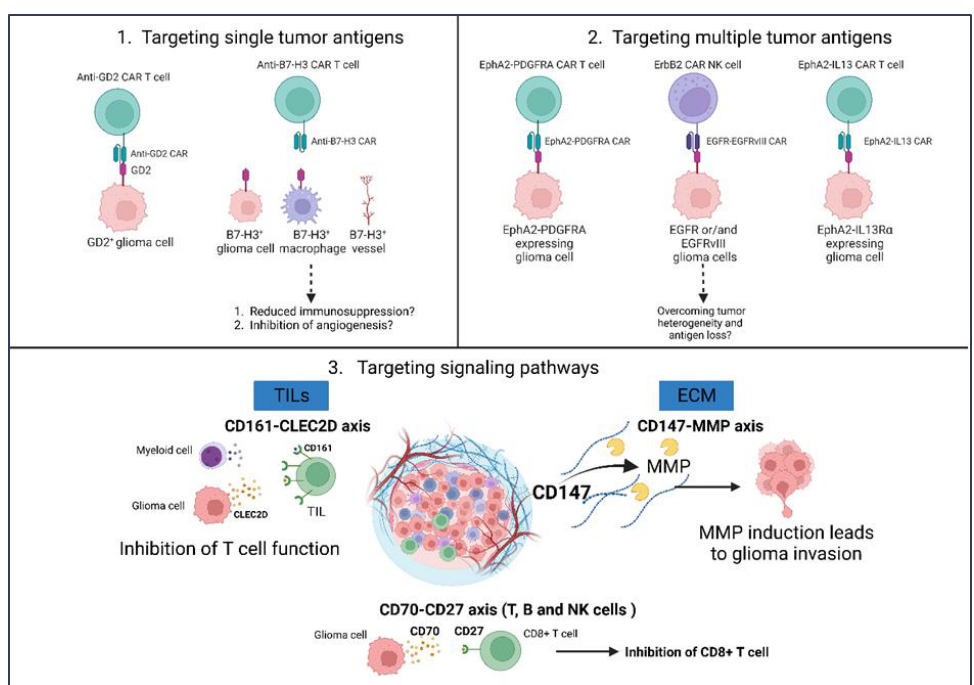
Figure 4. Potential targets for glioma immunotherapy. (1) Single antigens such as GD2 or B7-H3 were targeted using CAR-T therapy in pre-clinical trials and are currently being tested as part of ongoing clinical trials. (2) Targeting multiple antigens is considered an alternative and more efficient strategy compared with targeting a single antigen in glioma therapy. (3) Targeting signaling pathways is also being tested as an alternative route in glioma therapy. GD2—disialoganglioside; B7-H3—B7 homolog 3; EphA2—ephrin receptor A2; ErbB2—erythroblastic leukemia viral oncogene homolog 2; PDGFRA—platelet derived growth factor receptor α; MMP—matrix metalloproteinases; CLEC2D—C-type lectin domain family 2 member D. Created with BioRender.com (accessed on 14 March 2023).